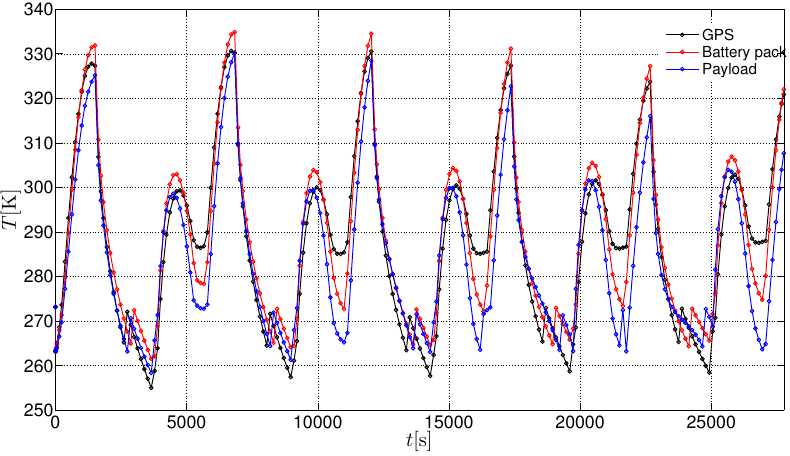
Figure 13. Average temperature in the electronic boards as function of time ( β = 0 ◦